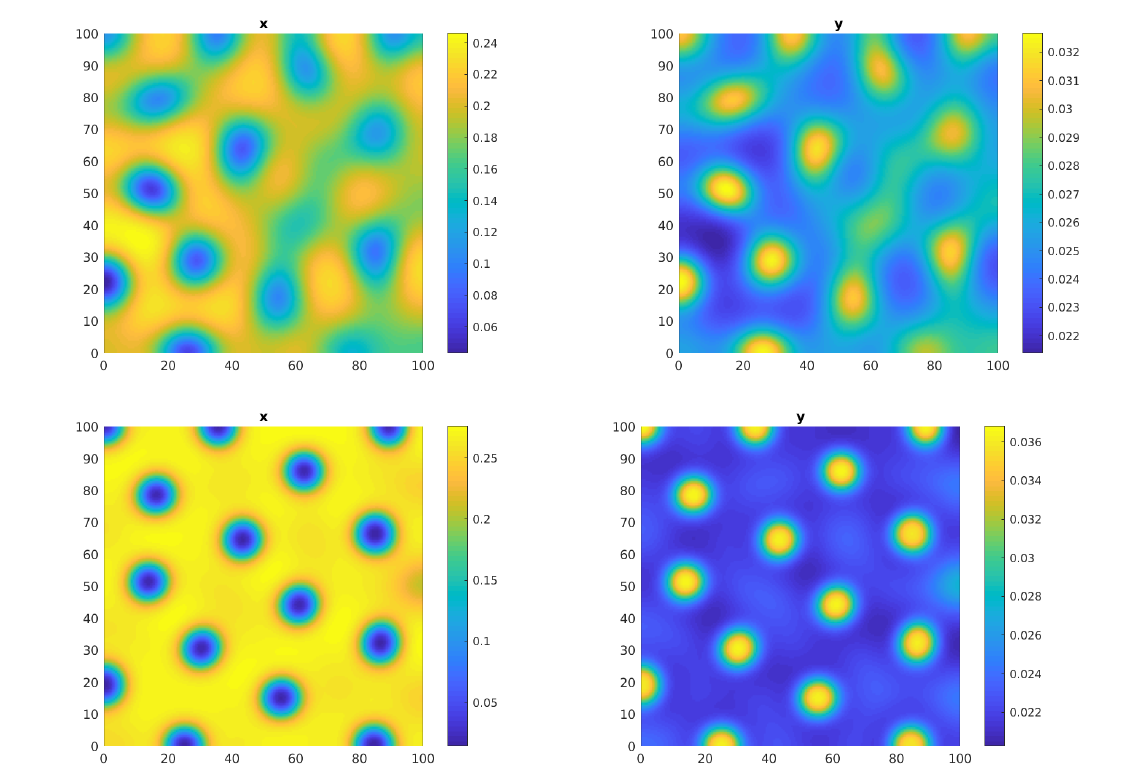
Figure 10. Plots of the solutions x and y of system (2)–(5) in the parameter setting of Example 2 for T = 1500 (first row) and T = 3000 (second row). Here γ 11 = 0.1, γ 22 = 10, γ 12 = 0.01 and γ 21 = 0.8.